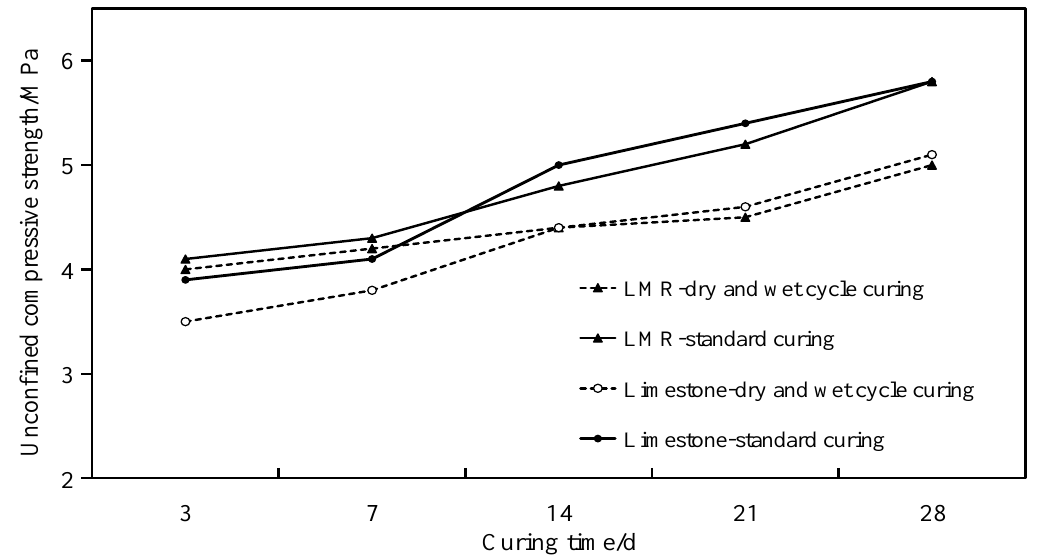
Figure 3. The strength of CSPB specimens with LMR and limestone aggregates.